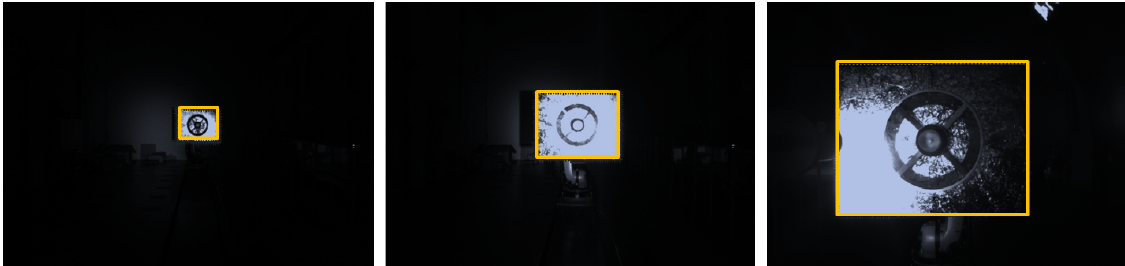
Figure 16: Examples of camera images captured with a Prosilica GC-655M showing a client satellite mockup in the laboratory at different distances. The detected edges are marked with orange color.